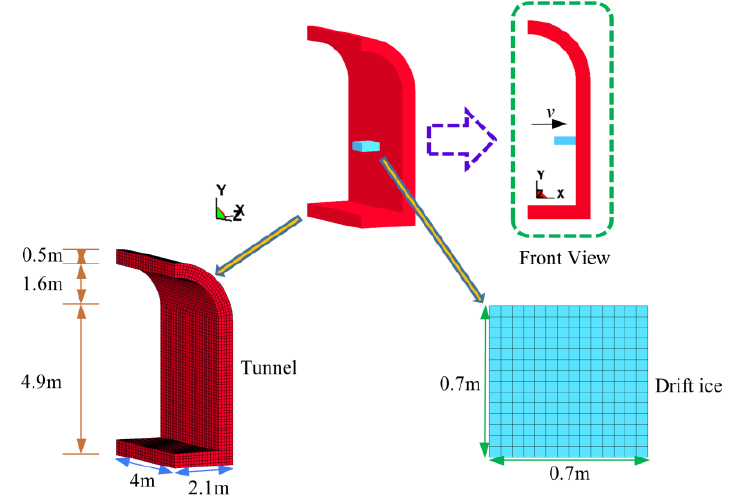
Figure 1. Additional mass model.